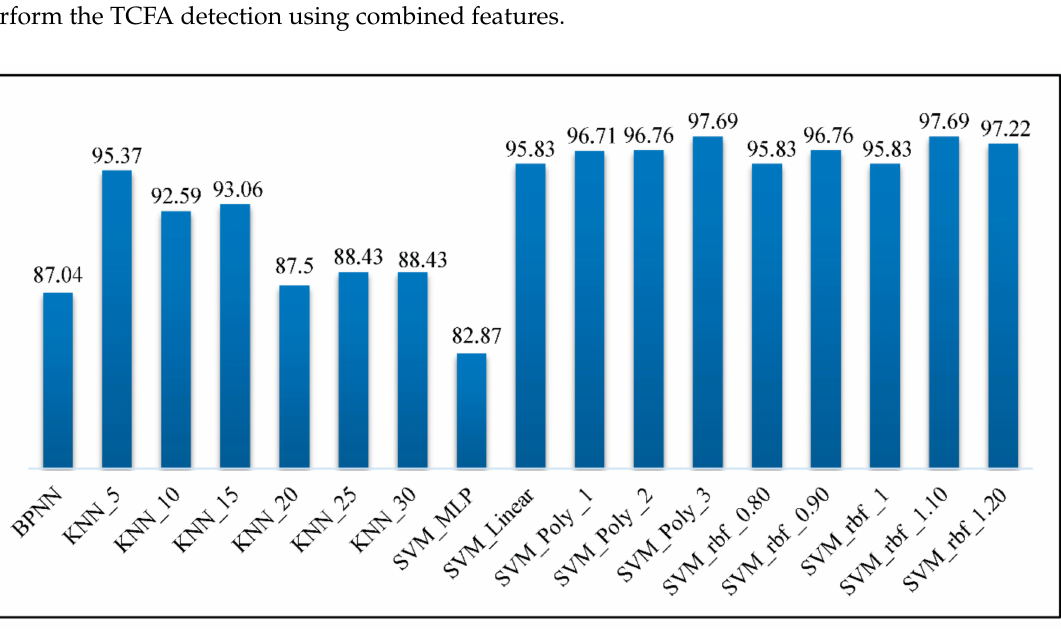
Figure 12. Accuracy measures of multiple classifiers obtained using geometrical